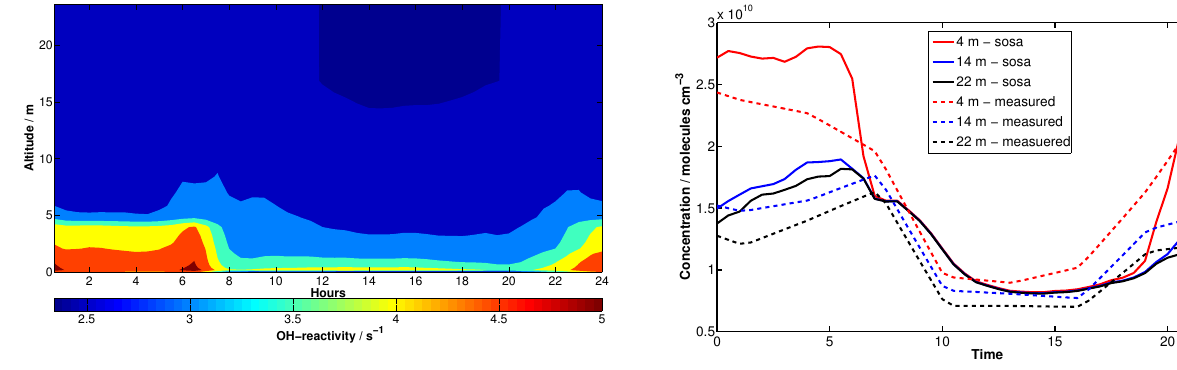
Fig. 8. Daily averaged modelled (named “sosa”) and measured sum of monoterpene concentration for 4, 14, and 22m. The averaging of monoterpene concentration for 4, 14, and 22m. The averaging has been done for 26 July to 10 August 2008. has been done for 26 July to 10 August